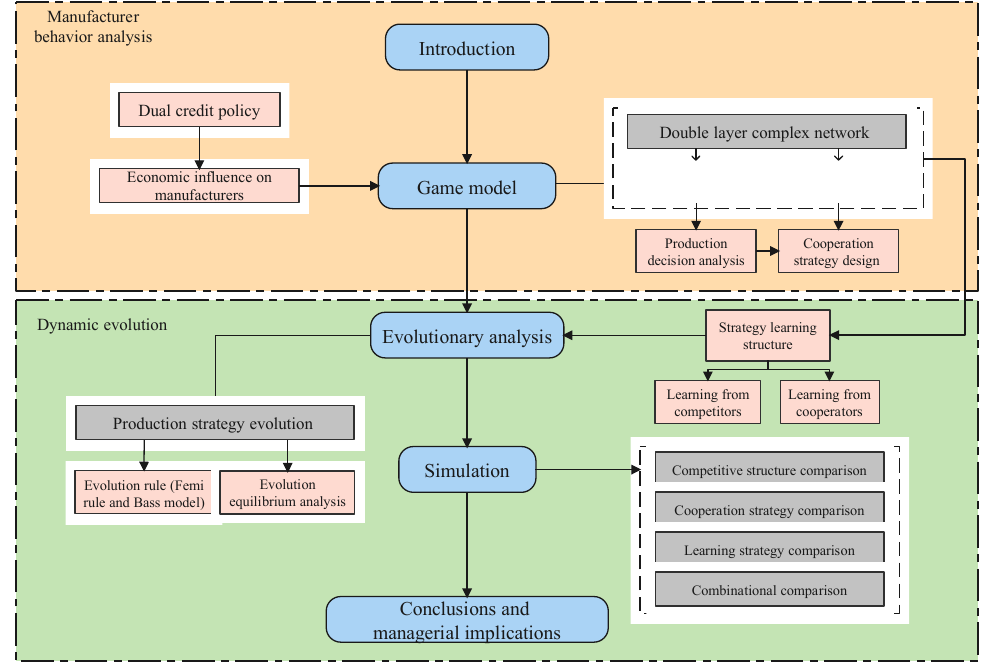
Figure 1. Analytical framework.